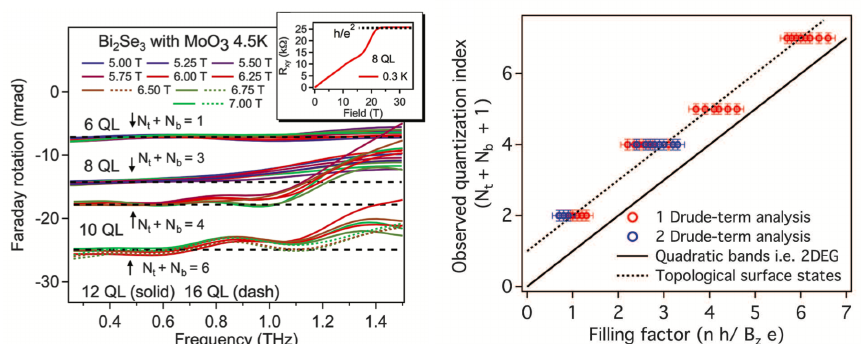
Figure 13: Left) Quantized Faraday rotation for different Bi lines are theoretical expectation values assuming certain values for the filling factor of the surface states. (inset) dc transport Hall resistance of a representative 8-QL sample. Right) Measured quantization index versus filling factor. The solid line is the expectation for quadratic bands, and the dashed line is for two topological surface states. From Ref. [ 64 ]